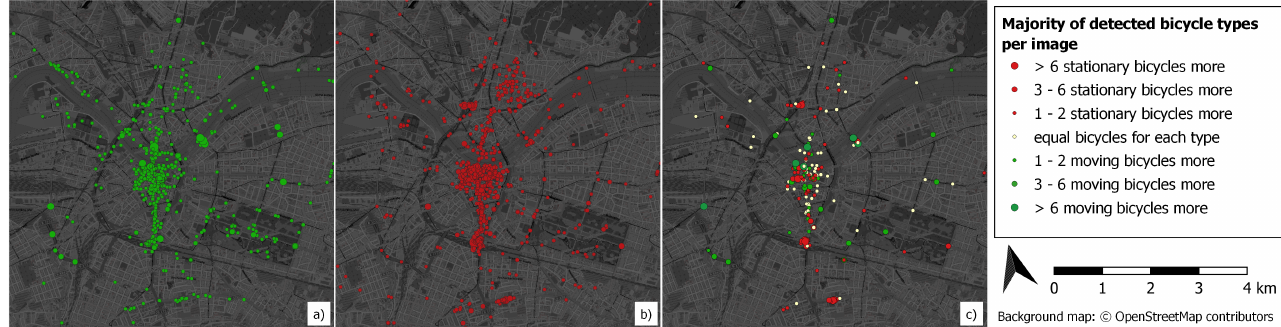
Figure 10. Spatial distributions of classified bicycle types. ( a ) Moving bicycles; ( b ) stationary bicycles; ( c ) images with both moving and stationary bicycles. Scale and orientation are equal for all